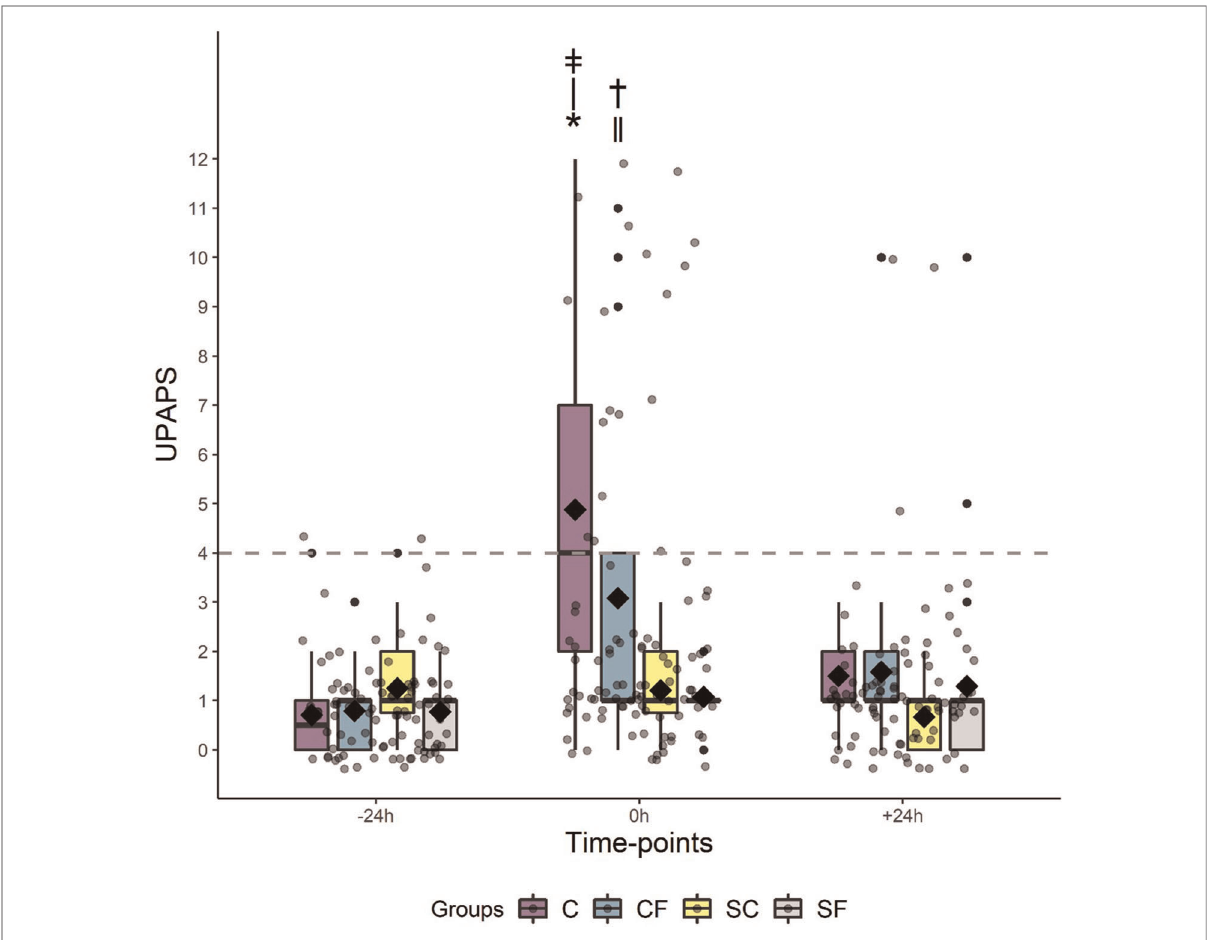
FIGURE 3 Boxplot for rescue analgesia for piglets in the C, CF, S and SF groups per timepoints at − 24 h, 0 h and 24 h using a cutoff=4. Chi square X 2 with P ≤ 0.05: * ǂ C vs. †